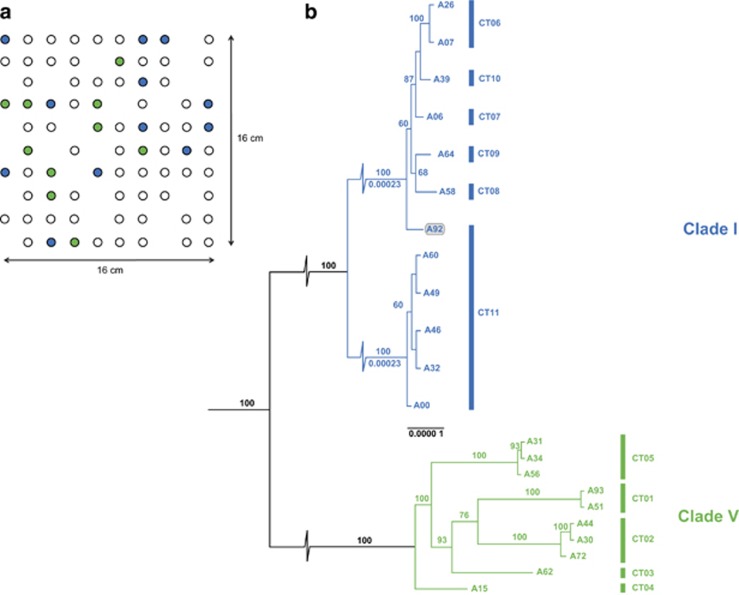
Spatial and phylogenetic relationships of the 22 M. xanthus clones. (a) Spatial sampling context of the 22 focal A strains. Of 100 samples taken from a 10 × 10 (16 × 16 cm) sampling grid, single M. xanthus clones could be isolated from 78 samples (circles). Strains were numbered from left to right, starting with A00 at the top left corner, ending with A99 at the bottom right. Clade I genotypes (blue) and clade V genotypes (green) could initially be distinguished based on the sequencing of three housekeeping genes that were identical within each clade. Both genotypes were the two most common types in the population (15 isolates each). (b) Maximum likelihood phylogeny of 22 focal A strains. Whole genomes of 12 members of clade I and 10 clones from clade V were analysed by mapping reads to both the reference strain DK1622 to confirm the overall branching order (black branches), and separately to either A00 (clade I, blue branches) or A15 (clade V, green branches) to increase resolution within clades. The latter subtrees were based on separate phylogenetic analyses and the alignments of 7.6 Mbp of conserved sequence each. Bootstrap values >60% are indicated on top of branches. The very long internal branches in clade I were broken to allow for better visualisation of the short final branches. Branch lengths are indicated below bootstrap values and branch length scale is indicated in substitutions per site. Compatibility-type (CT) grouping for each clone is indicated on the right-hand side. Strain A92 is shown in grey to highlight the incongruence of its phylogenetic position and CT grouping (see text).